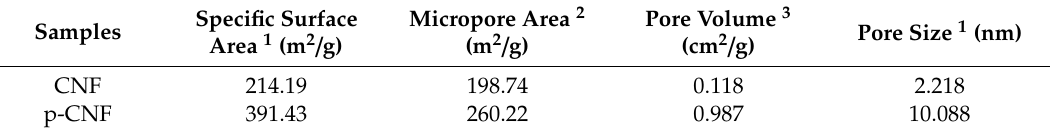
Table 1. Pore characteristics of CNF and p-CNF.